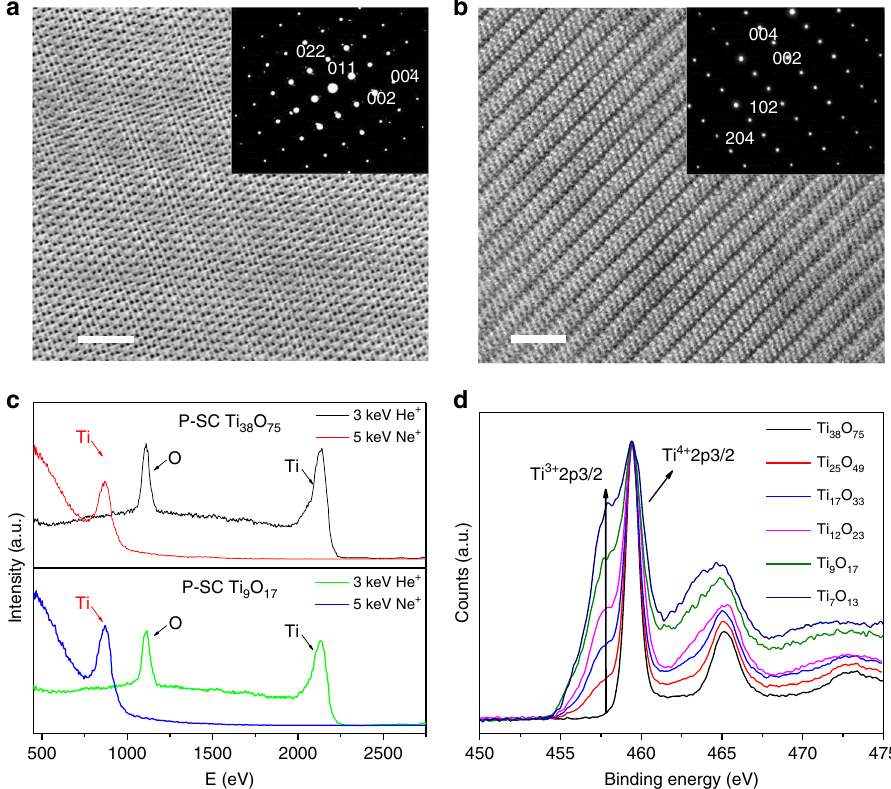
Fig. 3 Surface and bulk structures of P-SC Ti n O 2 n – 1 crystals. a Spherical aberration corrected Scanning Transmission Electron Microscope (Cs-corrected STEM) image of the P-SC Ti 38 O 75 view towards (011) plane and along c axis. Inset image shows the corresponding SAED pattern of P-SC Ti 38 O 75 . b Cs- corrected STEM image of the P-SC Ti 9 O 17 view towards (102) plane and along c axis. Inset image shows the corresponding SAED pattern of P-SC Ti 9 O 17 . c High-sensitive low-energy ion scattering (HS-LEIS) spectra of the outmost surface layer of P-SC Ti 38 O 75 and Ti 9 O 17 under the ion sources of 3 keV He + and 5 keV Ne + , respectively. d XPS spectra of P-SC Ti n O 2 n − 1 samples with different n values. The scale bar is 2 nm in ( a ) and ( b